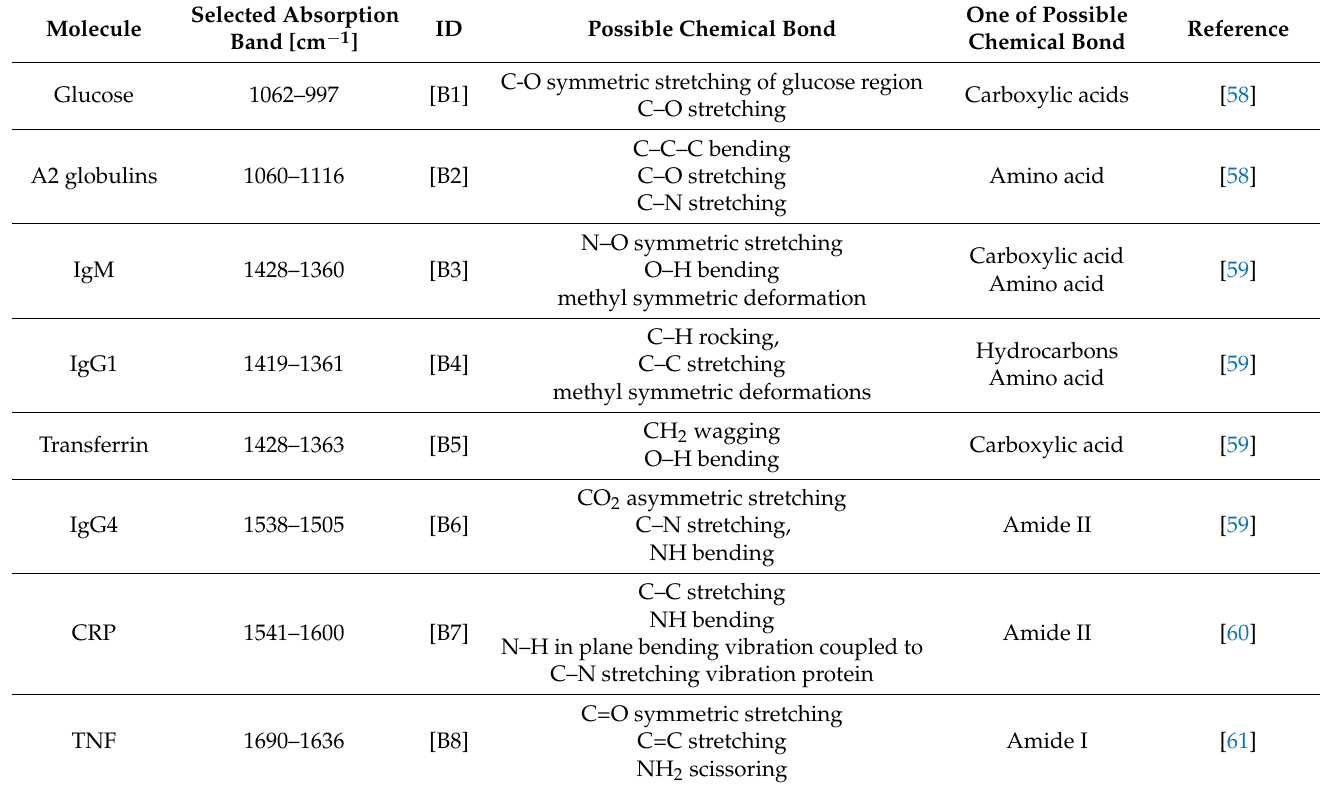
Table 3. Molecules identified in the IR spectra of guinea pig sera.